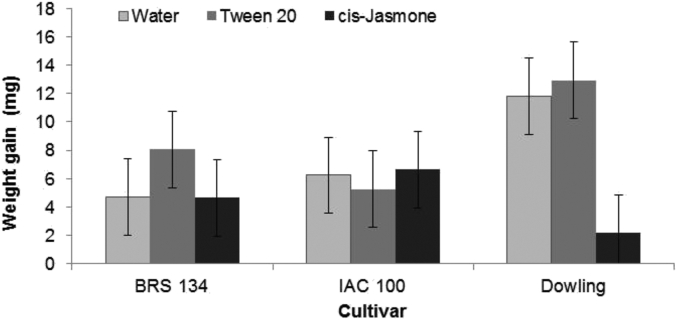
Weight gain of Euschistus heros fed on three soybean cultivars (BRS 134, IAC 100 and Dowling), after H2O, Tween 20 and cis-jasmone spray treatment, considering the cultivar by treatment interaction (P < 0.05, Table 1). Mean ± LSD (SED: 6.76) values are shown; replication, n = 30.